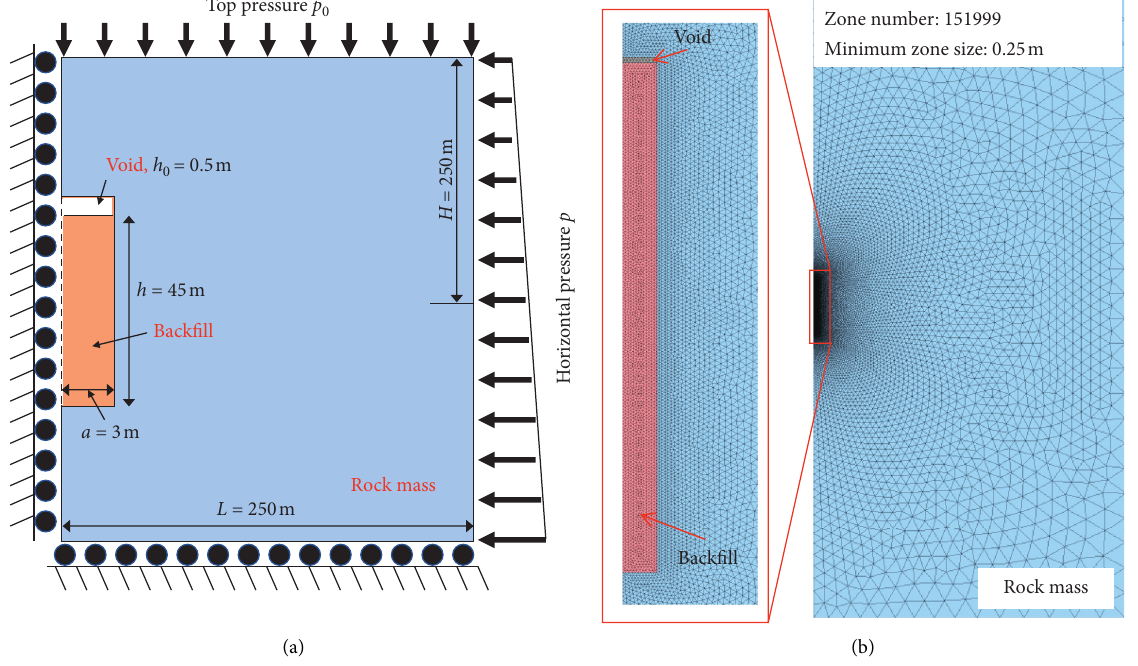
Figure 11: A schematic view of the numerical model: (a) size/boundary settings and (b) grid model.